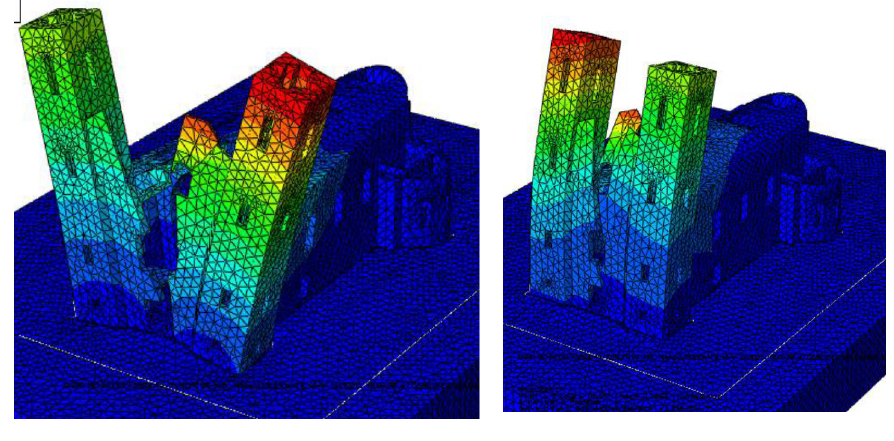
( a ) First “north-south” mode—0.302 Hz; ( b ) First “east-west” mode—0.517 Hz Figure 17. Modal analysis—first modes in two orthogonal directions. Figure 17. Modal analysis—first modes in two orthogonal